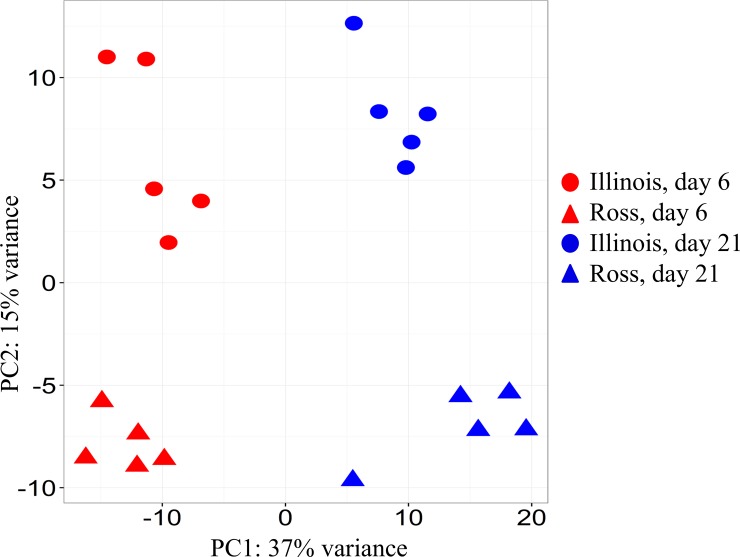
Principal component analysis showed distinct clustering of samples in different groups in different colors.Principal component 1 (PC1) in horizontal axis and PC2 in vertical axis explain 37% and 15% of variation in variance-stabilized normalized counts, respectively.